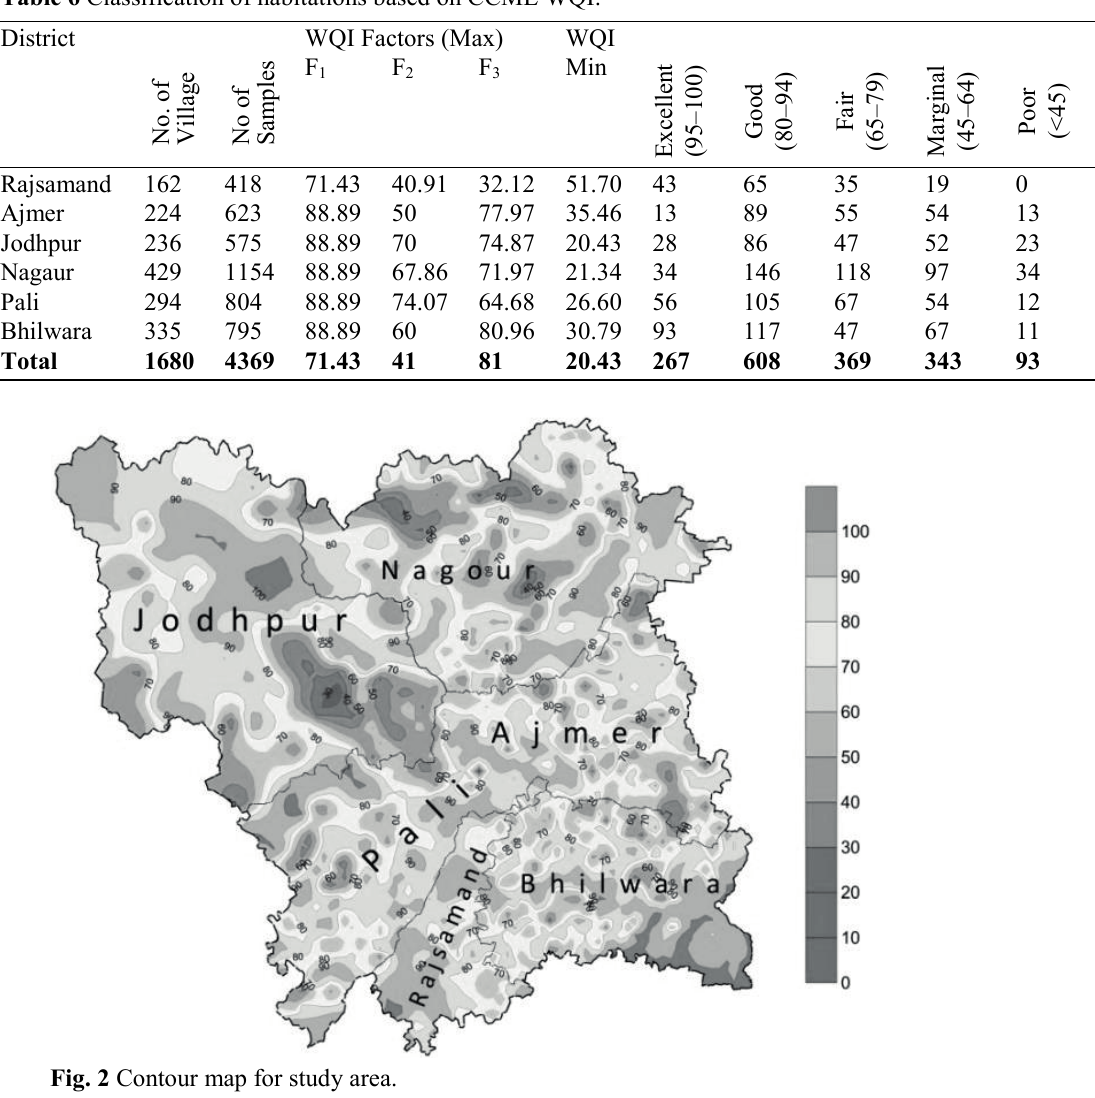
Table 6 Classification of habitations based on CCME WQI.